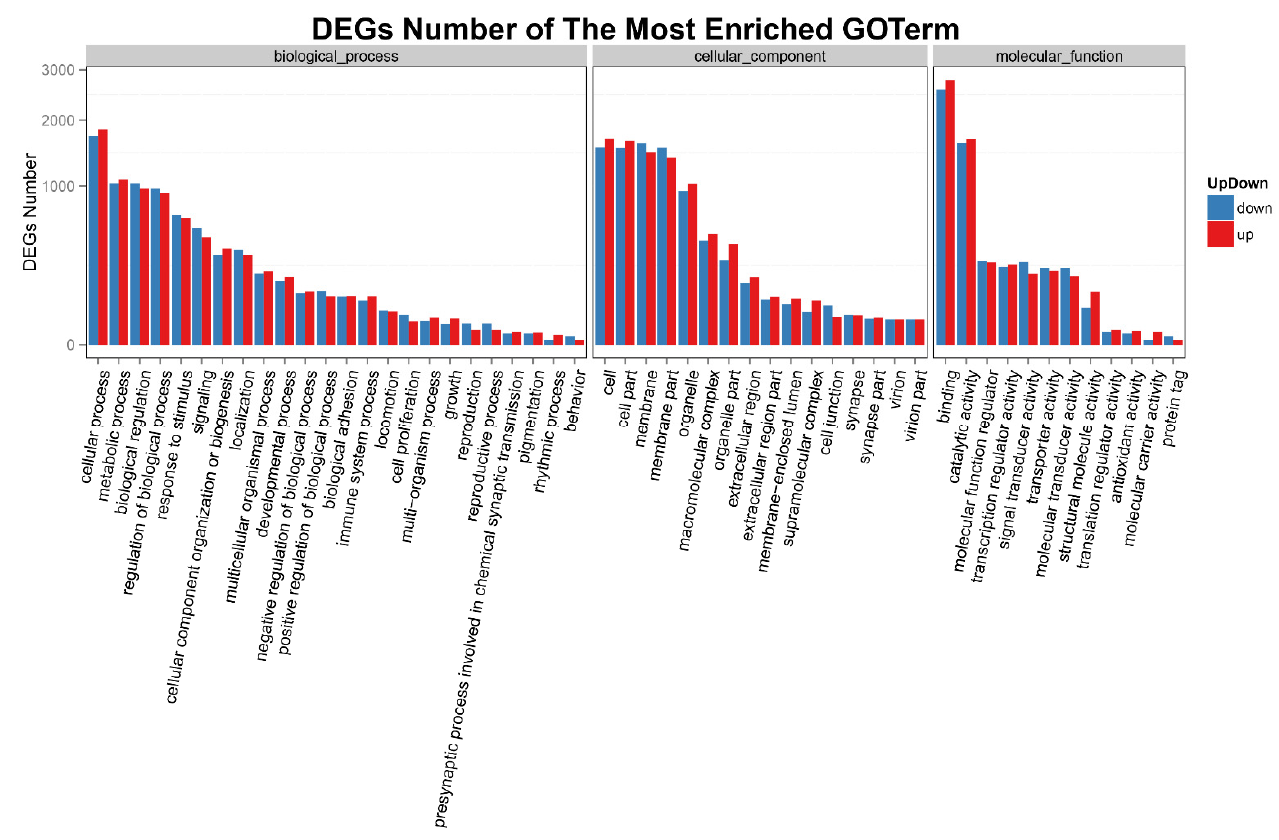
Figure 3. GO analysis of DEGs in the head kidney of rainbow trout after post-22.5 °C stress. The X - axis represents the GO functional classification, and the Y -axis represents the number of up-regulated or down-regulated genes corresponding to GO term; the red is the number of up-regulated genes, and blue is the number of down-regulated genes.